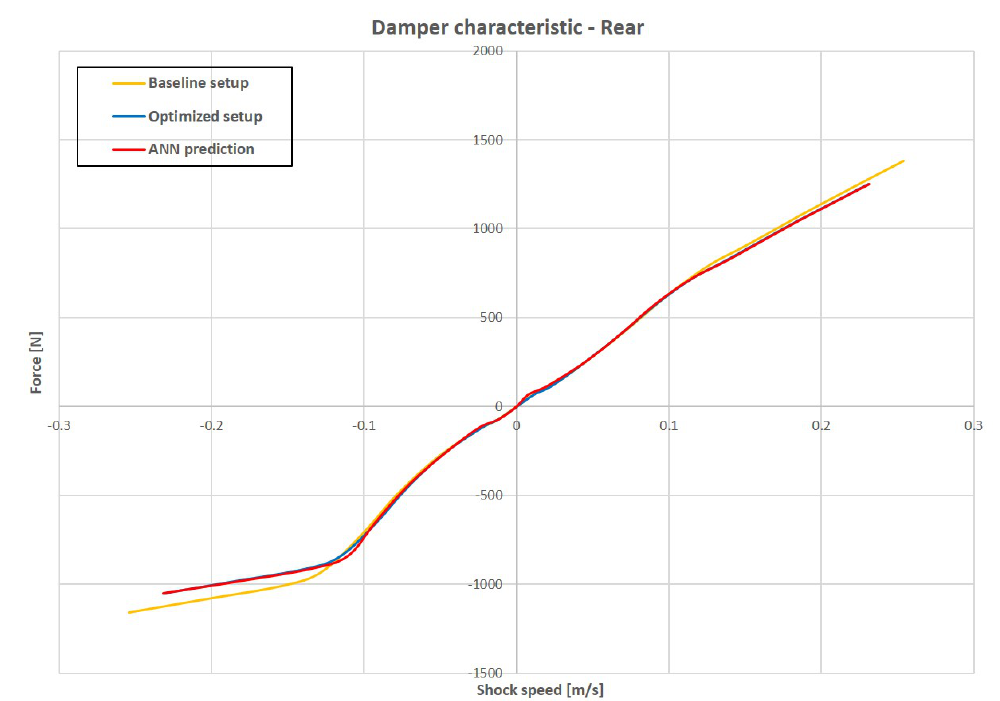
Figure 34. Rear damper characteristic comparison.